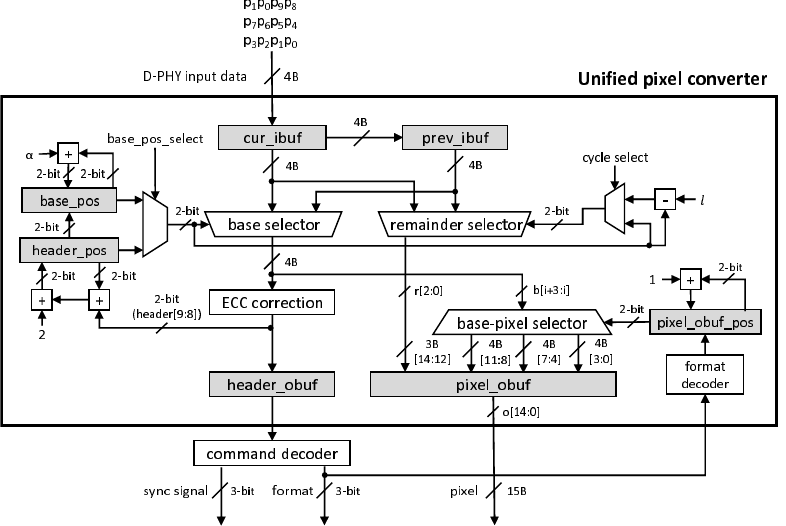
Figure 5. Our unified pixel converter and a command decoder. The gray box represents for a